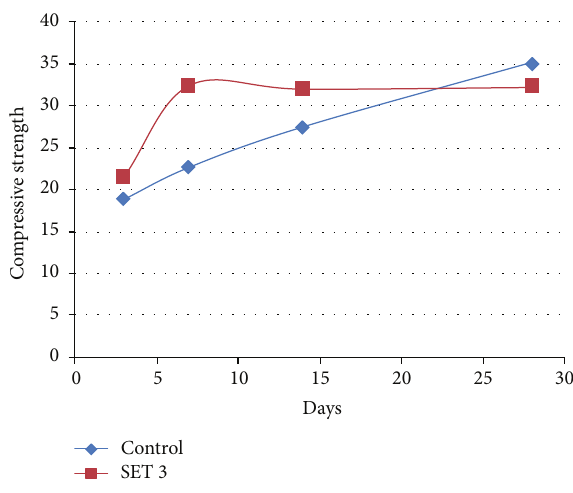
Figure 3: Comparison of control concrete with Set